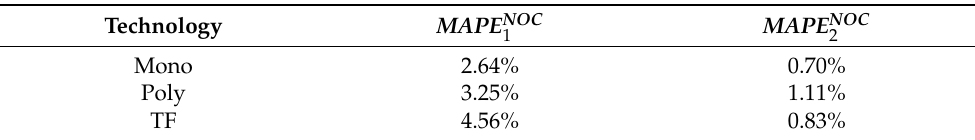
Table 7. MAPE for monocrystalline, polycrystalline, and thin-films modules, under Normal Operat-